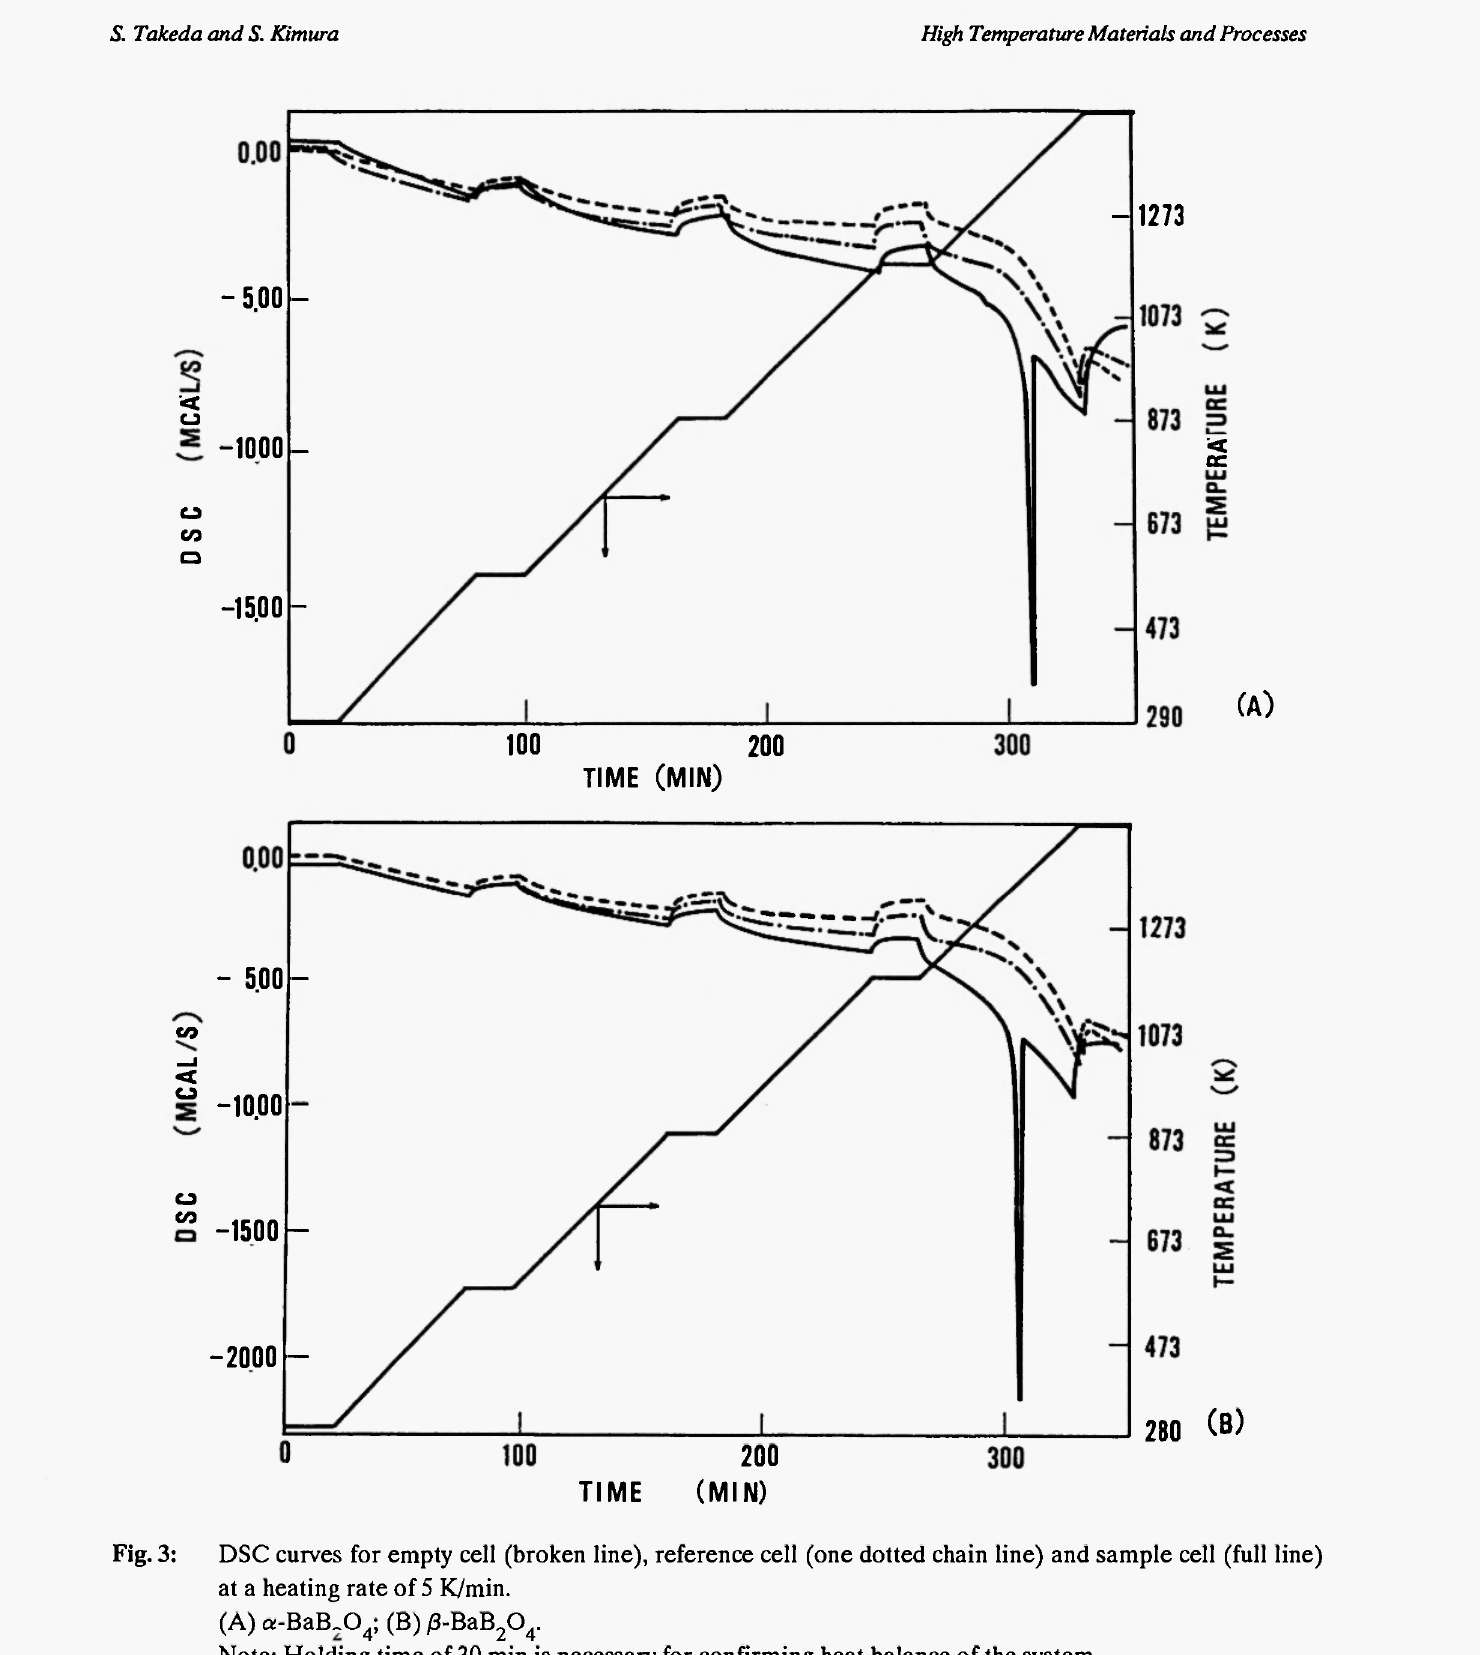
Fig. 3: DSC curves for empty cell (broken line), reference cell (one dotted chain line) and sample cell (full line) at a heating rate of 5 K/min. Note: Holding time of 30 min is necessary for confirming heat balance of the